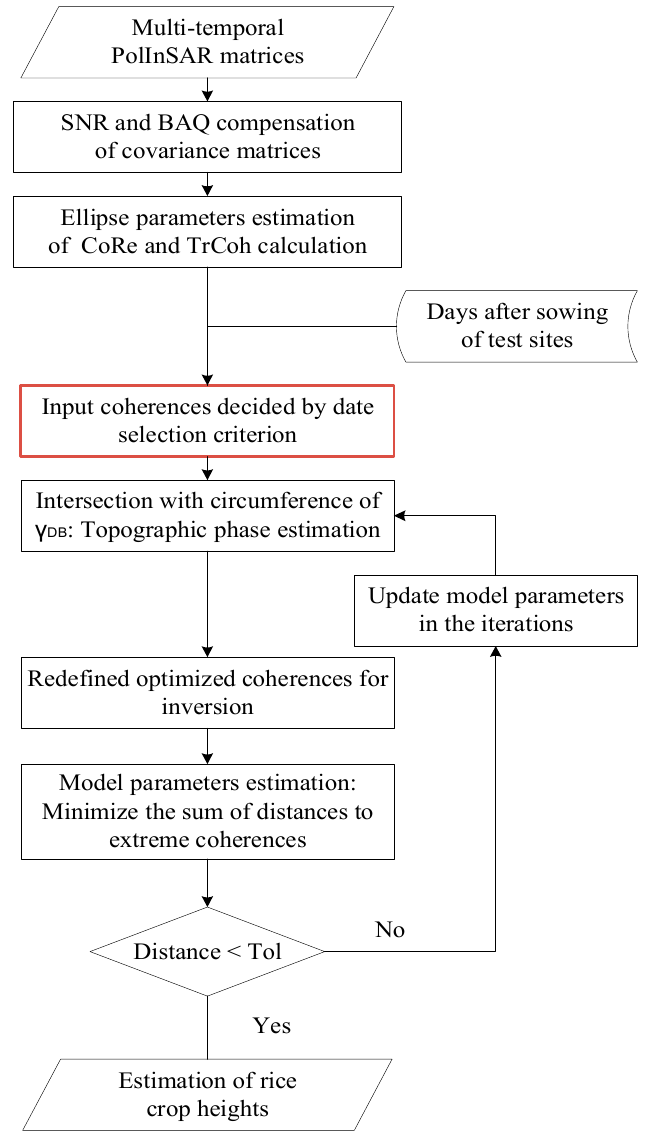
Figure 4. Flowchart of the time-series RVoG model based on the logistic growth equation.